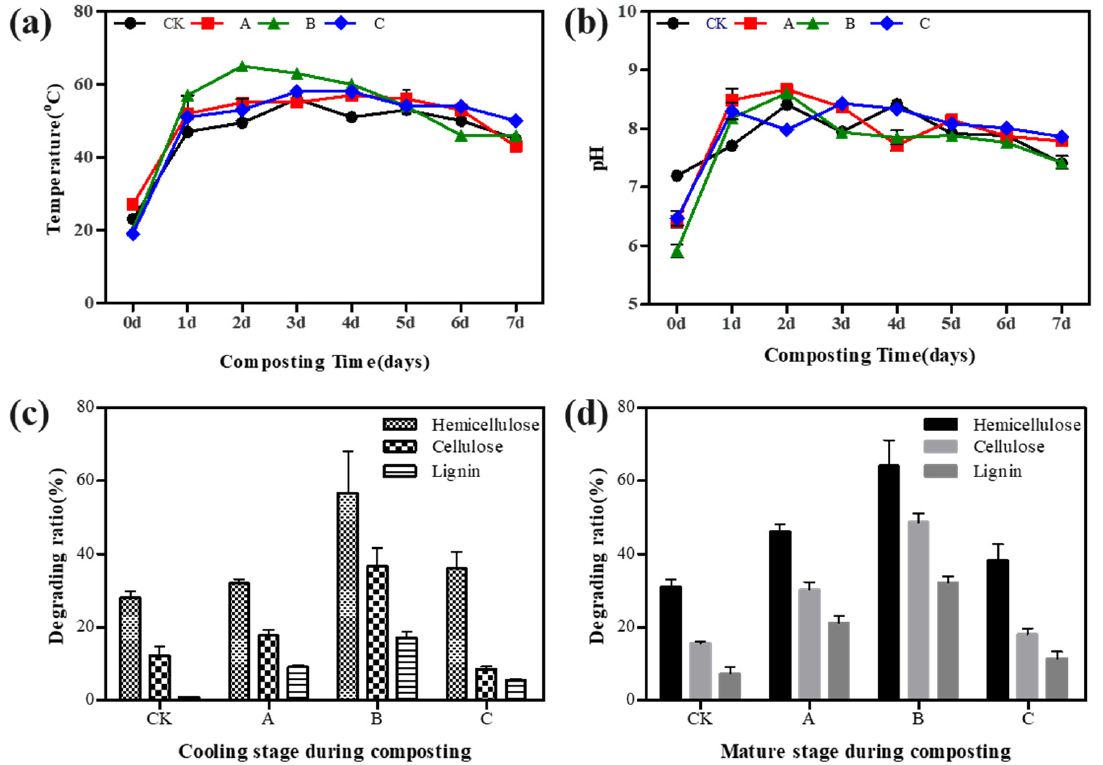
Figure 2. Temperature ( a ) and pH ( b ) changes of composts with different treatments. Lignocellulose content changes in the cooling stage ( c ) and maturation stage ( d ) of composts with different treatments.